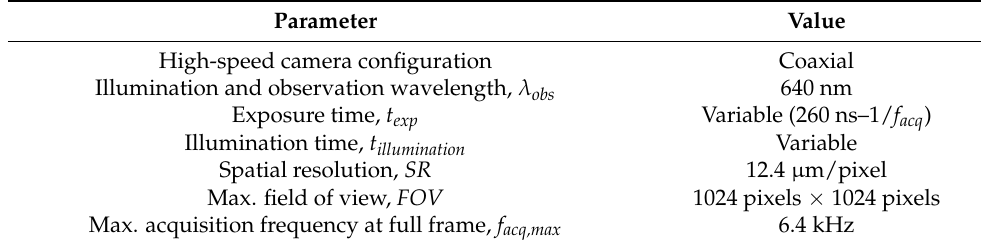
Figure 2. Schematic representation of the experimental setup ( a ) with coaxial illumination and ( b ) off-axis illumination. ( c ) Effective implementation of the laser and monitoring system. Table 4. Specifications of the monitoring chain